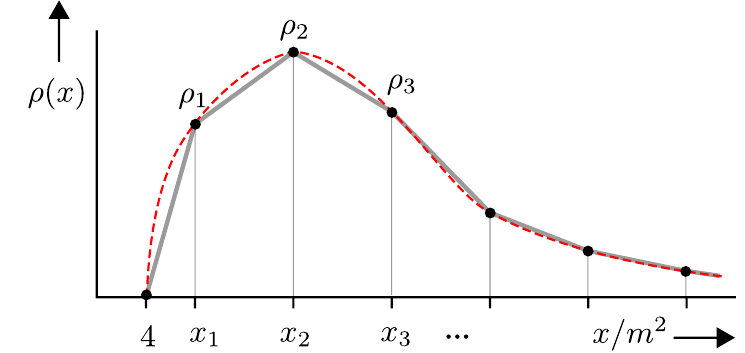
Figure 3 . Approximation of an arbitrary density with a linear spline. The red dashed line repre- sents some unknown (cid:26) ( x ) which we approximate with the grey spline passing through the points ( (cid:26) n ; x n ). Explicitly we have (cid:26) ( x ) (cid:26) n ( x (cid:0) x n +1 ) + (cid:26) n +1 ( x (cid:0) x n ) for x [ x n ; x n +1 ]. We use this ( x n x n +1 ) ( x n +1 x n ) (cid:25) 2 (cid:0) (cid:0) approximation up to some cuto(cid:11) x M after which we assume the density decays as (cid:26) ( x ) 1 =x . (cid:24) That is, we have (cid:26) ( x ) (cid:26) M x M =x for x x M which allows us to explicitly integrate the tail from (cid:25) (cid:21) x M to 1